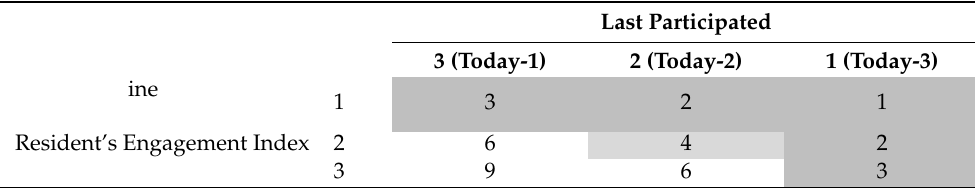
Table 1. Schedule Selector Index Look-up